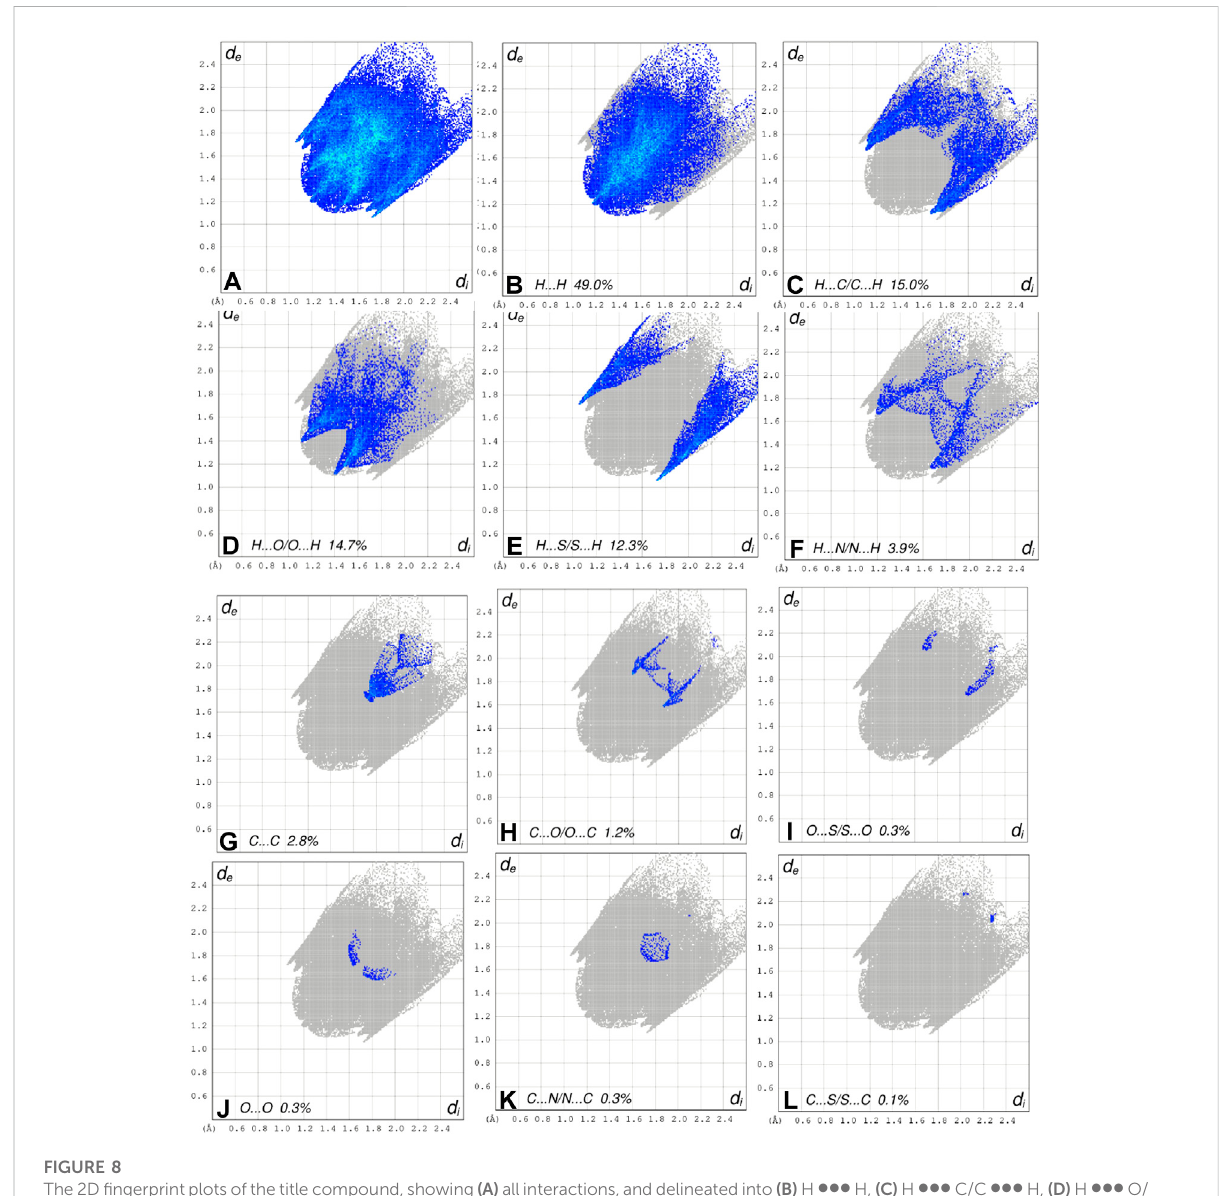
(cid:129)(cid:129)(cid:129) C/, (H) C